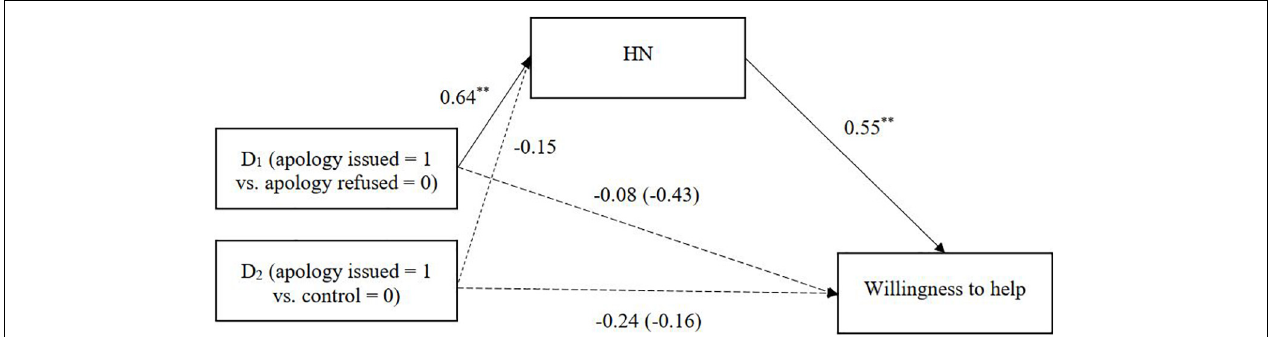
Condition → HN → expectation of a future relationship